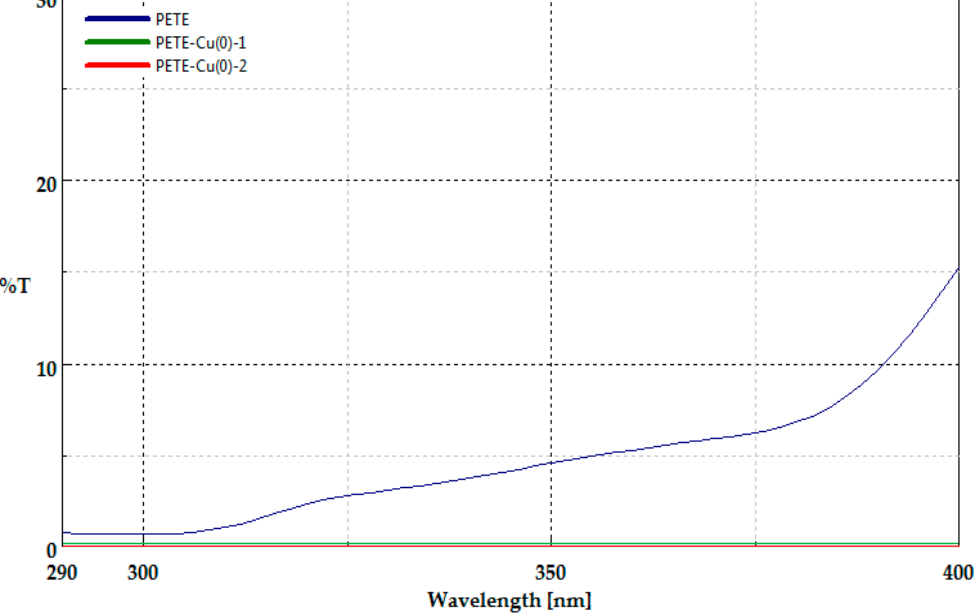
Figure 7. Comparison of transmittance spectra [%T] in the range λ = 290–400 nm of unmodified PETE knitted textile and PETE-Cu (0) composites (PETE-Cu (0) -1, PETE-Cu (0) -2).